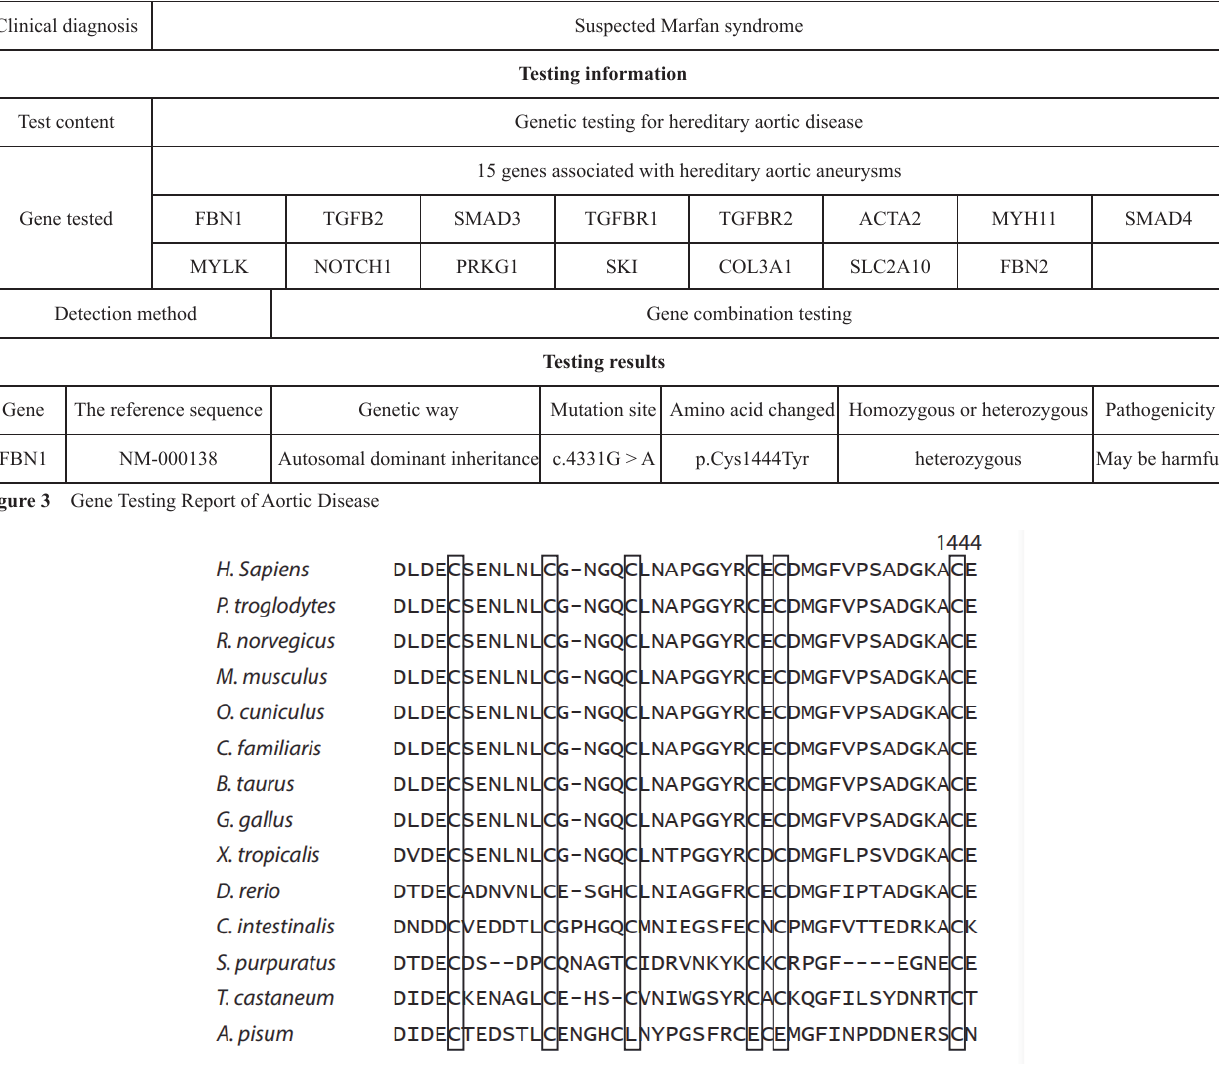
Figure 4 Orthologous protein sequence alignment of FBN1 from different species, the mutated residue showing conservation of cysteine at codon